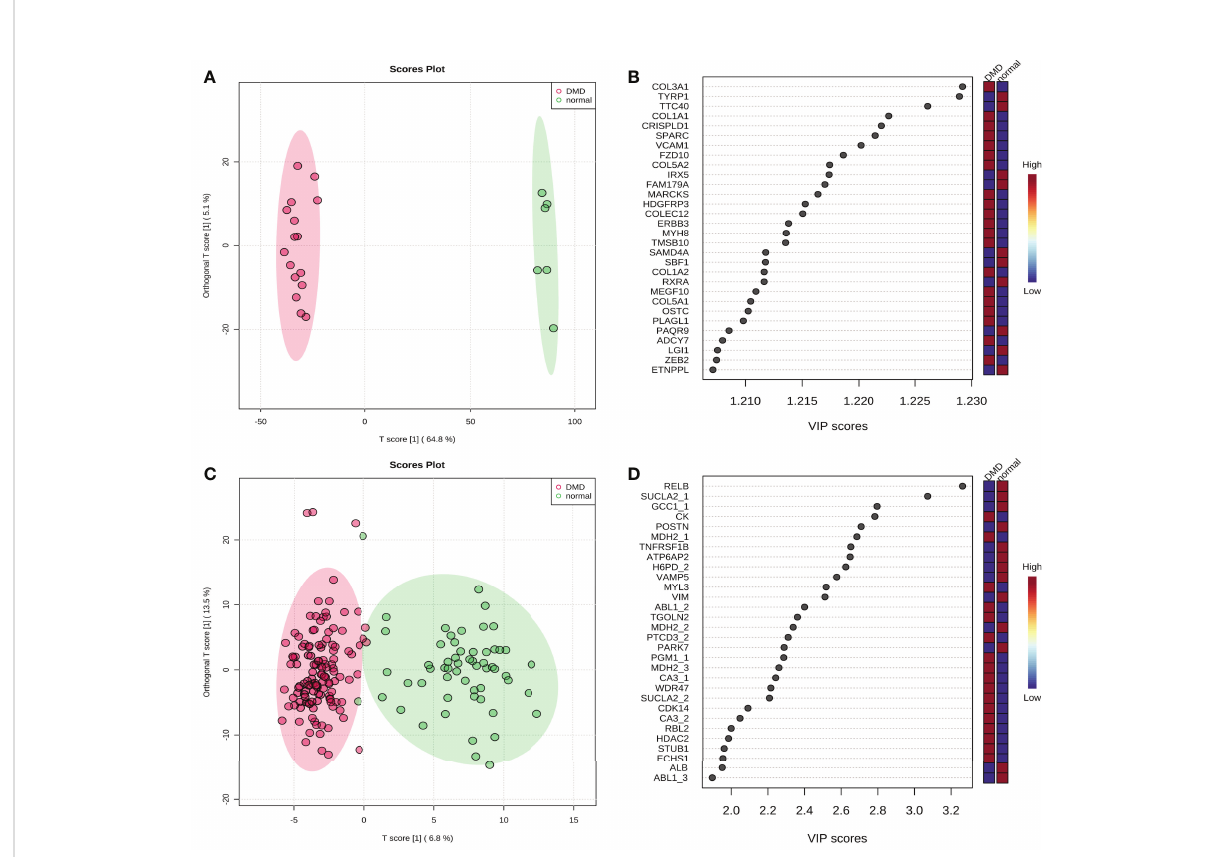
FIGURE 3 The score plot of Orthogonal Partial Least Squares - Discriminant Analysis. (A) GSE38417 dataset; (B) E-MTAB-2564 dataset; (C) the top 20 mRNAs according to VIP scores; (D) the top 20 proteins according to VIP